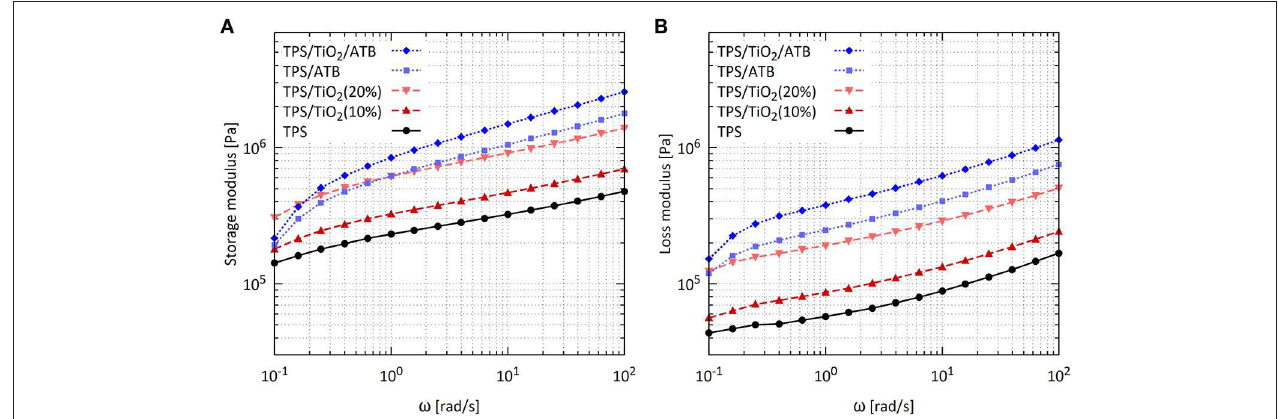
FIGURE 6 | Frequency sweeps from oscillatory shear rheometry: (A) Storage modulus G ′ and (B) loss modulus G ′′ (B) of the TPS/TiO 2 /ATB composites at 120 ◦ C and strain of 0.05%.